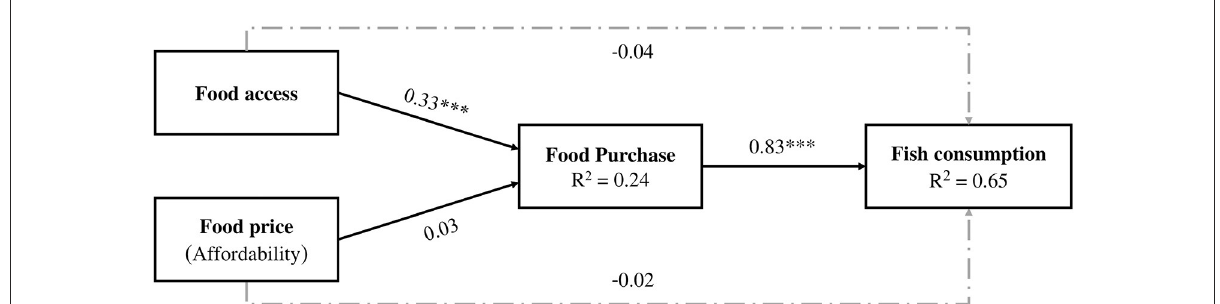
FIGURE3 Basic model with standardized coefficients (asterisk (*) showing statistically significance at p < 0.001). Good fits of the model indicated by Chi-square = 0.357 ( df = 2), p = 0.837, Comparative Fit Index (CFI) 1.000, Tucker-Lewis Index (TLI) 1.003, Root Mean Square Error of Approximation (RMSEA) 0.000, 90% CI (0.000, 0.047), Standardized Root Mean Square Residual (SRMR) 0.004. Model adjusted for age, gender, education, and HCI. Long dash dotted lines show the direct pathways.